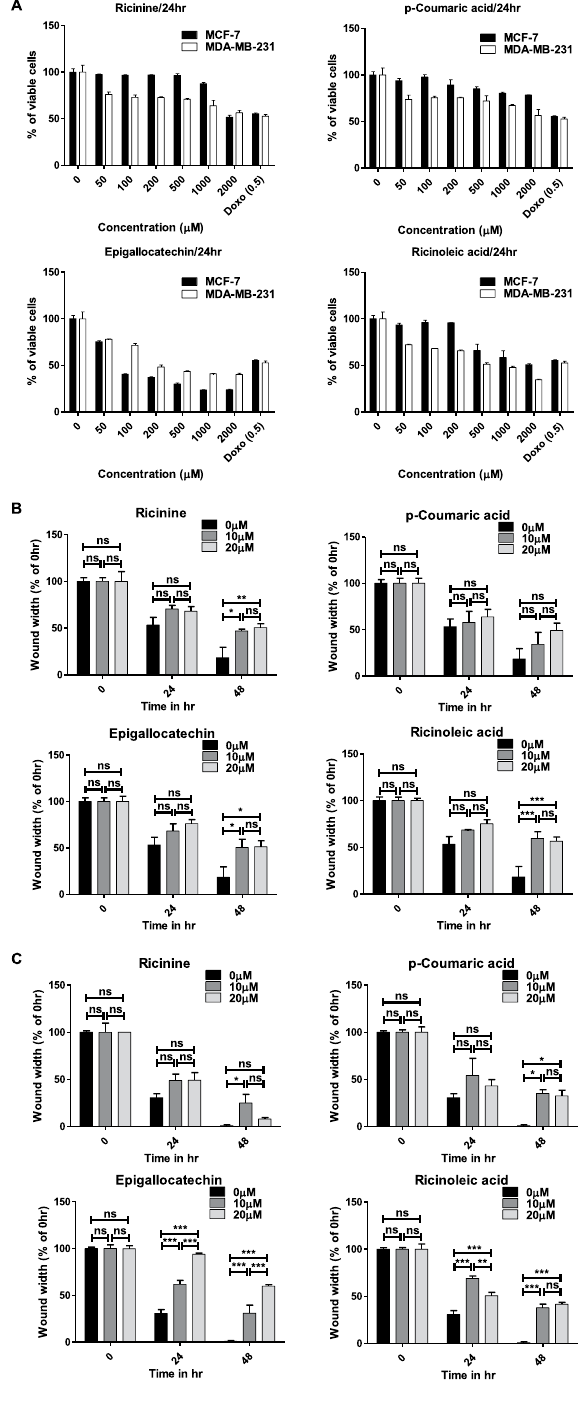
Figure 7. Pure compounds showed significant biological activity. ( A ) The cytotoxic effect of Ricinine, p-Coumaric acid, Epigallocatechin and Ricinoleic acid in MCF-7 and MDA-MB-231 cells after 24 hr treatment. Doxorubicin (Doxo) was used as positive control. Quantitative representation of migration of MCF-7 ( B ) and MDA-MB-231 ( C ) cells by wound healing assay. Data represent the mean ± SEM of three independent experiments. Statistical differences were analyzed with two-way ANOVA test for wound healing assay. p value ns > 0.05, p value *** <